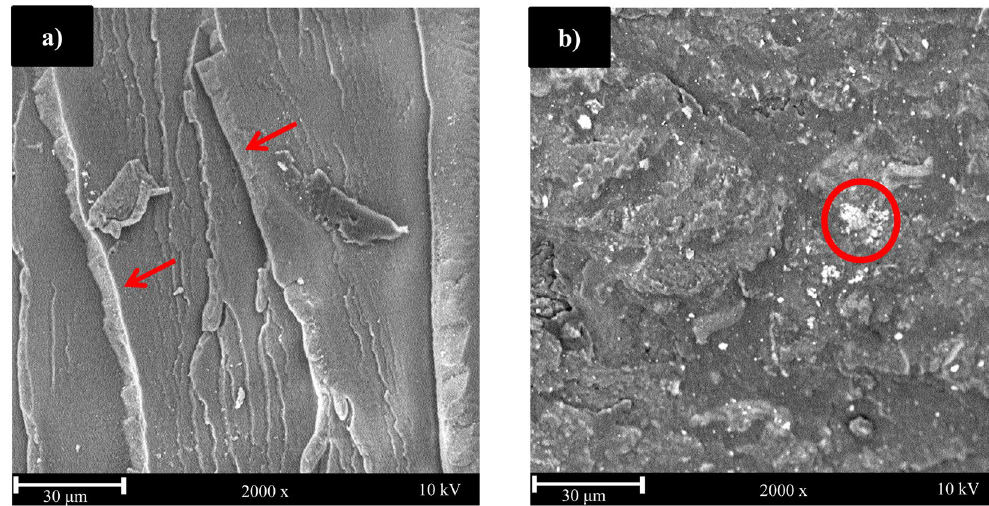
Figure 10. SEM images of ( a ) neat PTT and ( b ) 80wt.% PTT with 20 wt.% 500 ° C PH